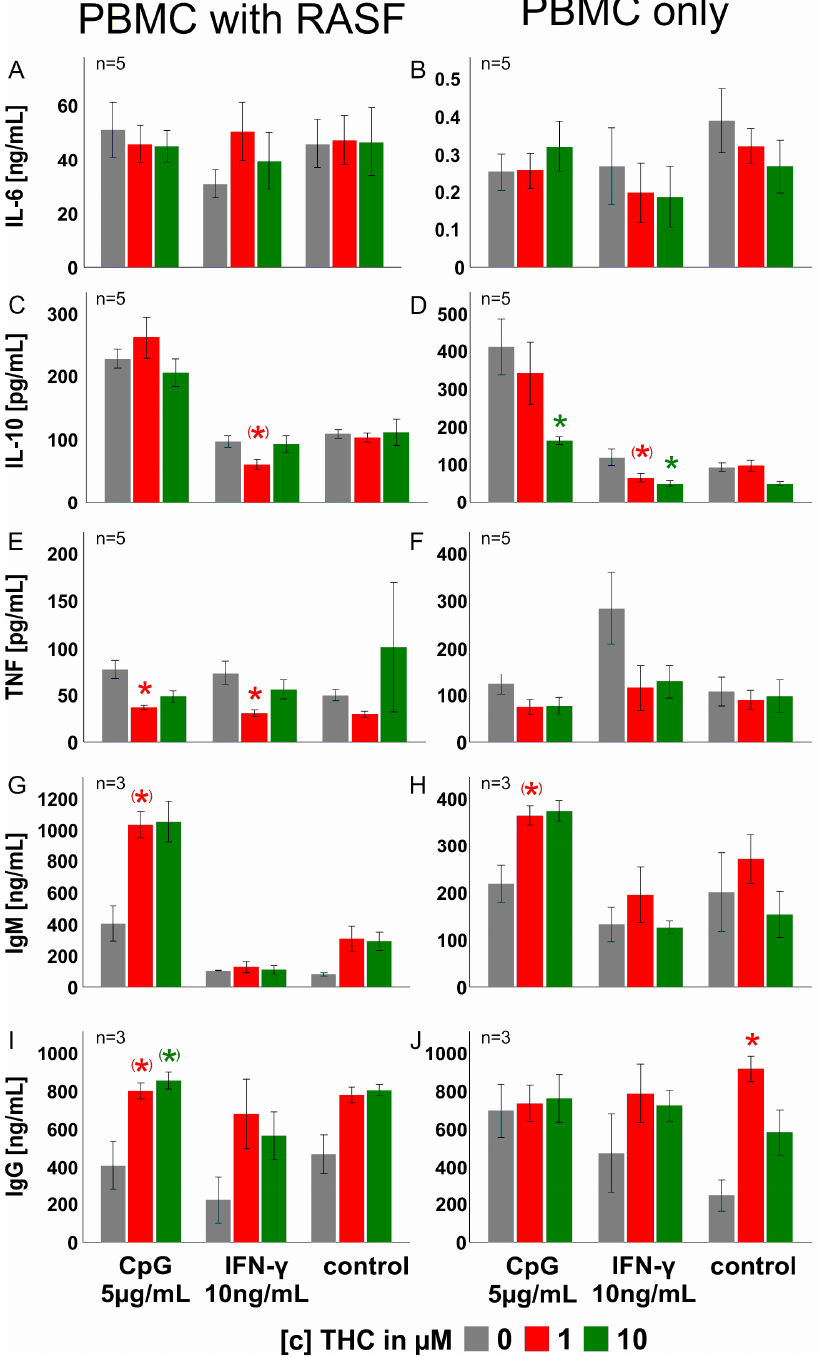
Figure 5. Cytokine production by human PBMC monoculture and co-culture with RASF in response to THC. ( A , B ) IL-6; ( C , D ) IL-10; ( E , F ) TNF; ( G , H ) immunoglobulin M (IgM) and ( I , J ) immunoglobulin G (IgG) production by PBMC and PBMC/RASF co-culture over 7 days. Cells were concomitantly stimulated with THC and the respective activation stimulus (IFN- γ or CpG). In co-culture experiments, RASF were stimulated with 10 ng/mL IFN- γ 72 h prior to PBMC addition to induce MHC II expression and induce an allogeneic T cell response. ANOVA with Bonferroni post hoc test was used for all comparisons. * p < 0.05.